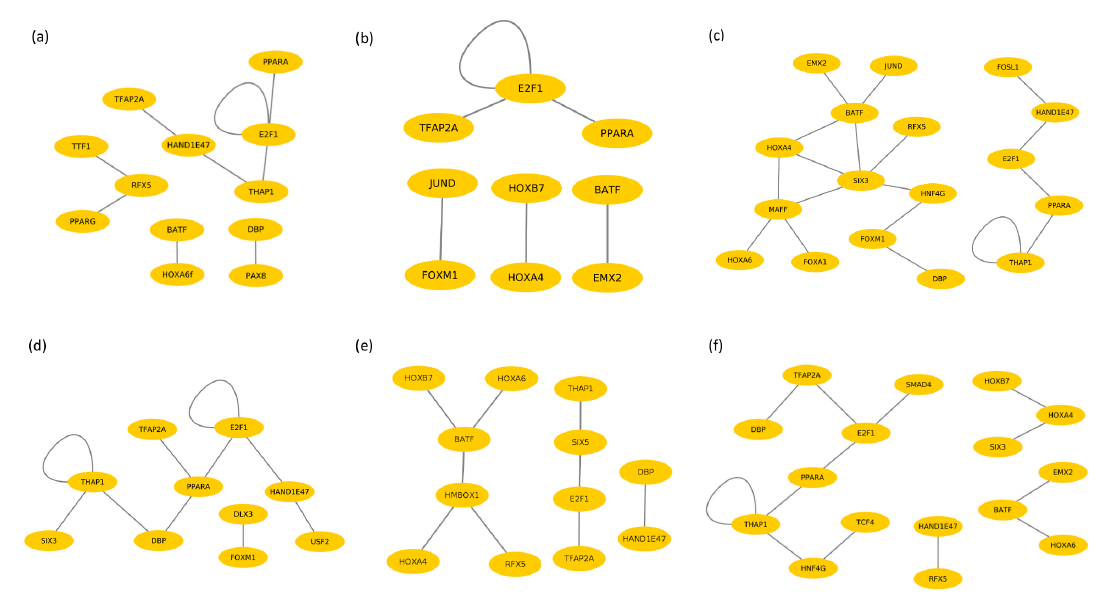
Figure 3. Cooperation networks for the TF pairs of ( a ) liver tissue of Boran, ( b ) spleen tissue of Boran, ( c ) lymph node tissue of Boran, ( d ) liver tissue of N’Dama, ( e ) spleen tissue of N’Dama and ( f ) lymph node tissue of